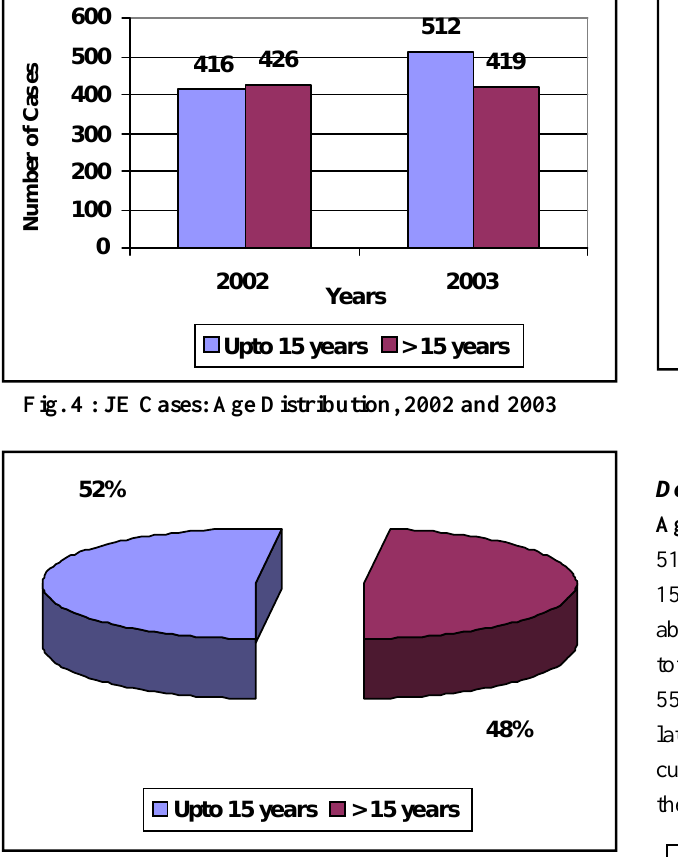
Fig. 5 : JE Cases: Cummulative Age Distribution, 2002 and 2003